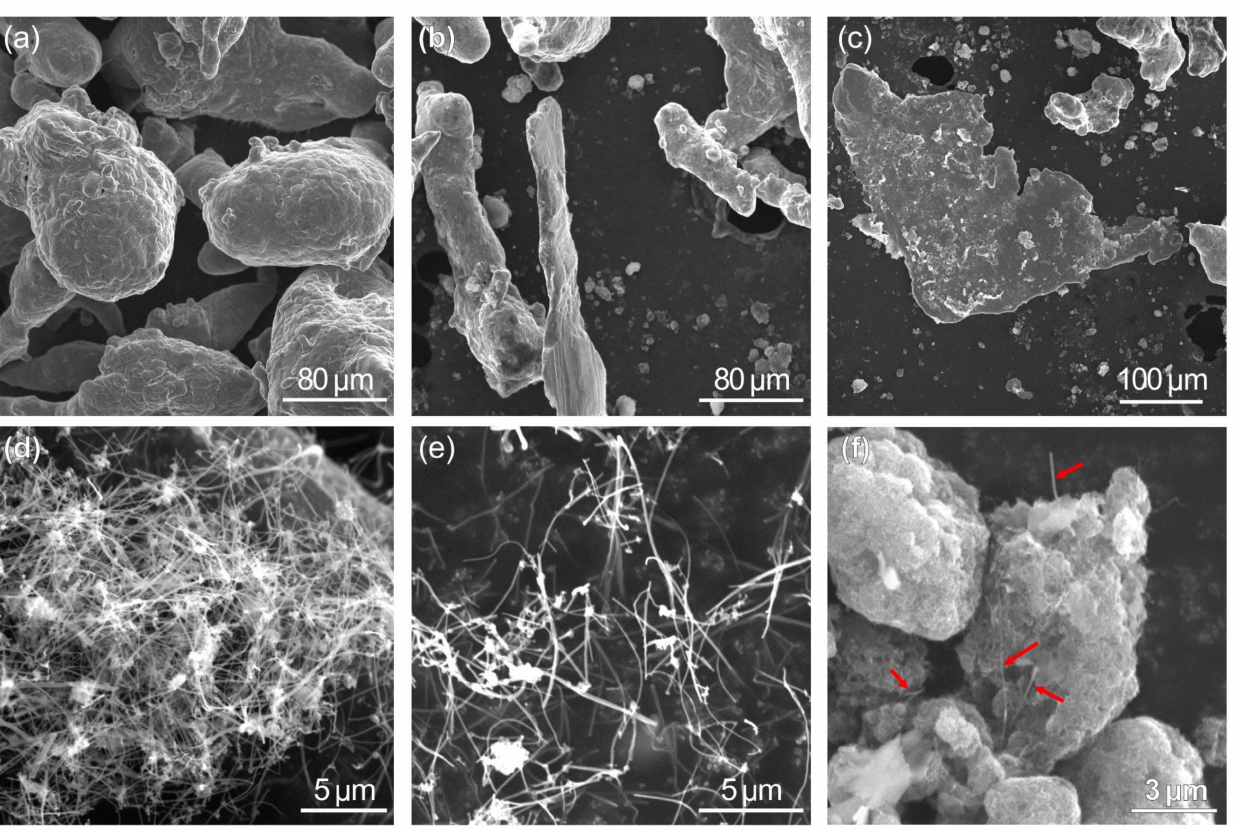
Figure 1. SEM images of ( a ) initial AA2024 powders used, ( b ) and ( c ) AA2024 powders after ball milling, ( d ) and ( e ) MWCNTs used and ( f ) powder mixture of AA2024 and MWCNTs after ball